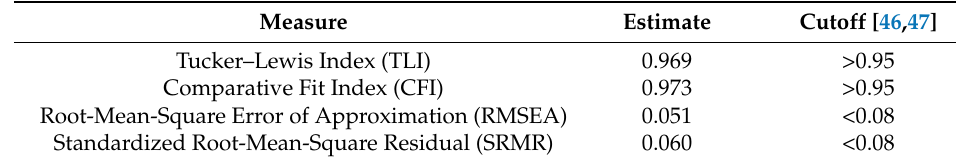
Table 3. Fit measures for Study 1.